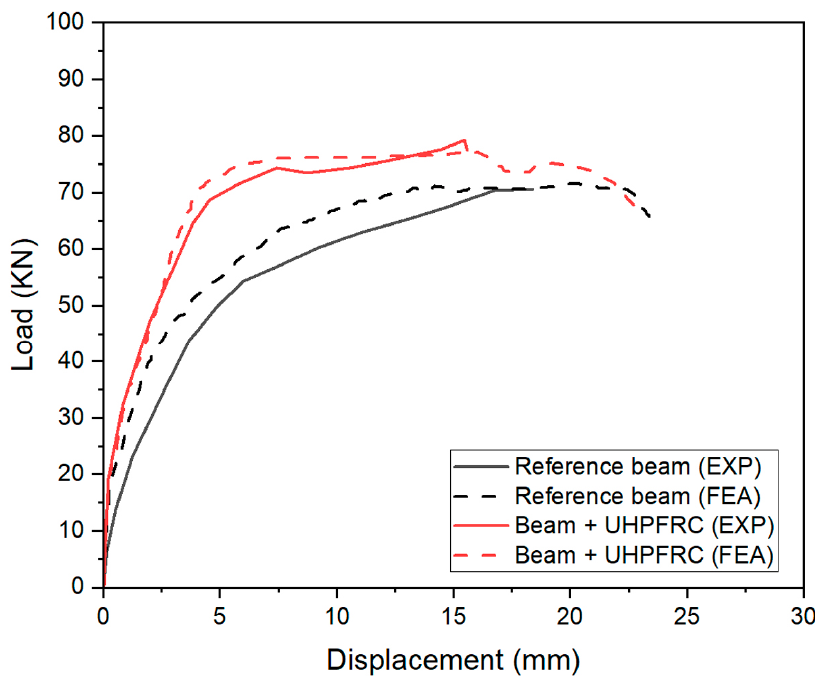
Figure 14. Comparison of load-displacement characteristics between the EXP [36] and FEM simula- tions in the flexural test for rough surfaces.